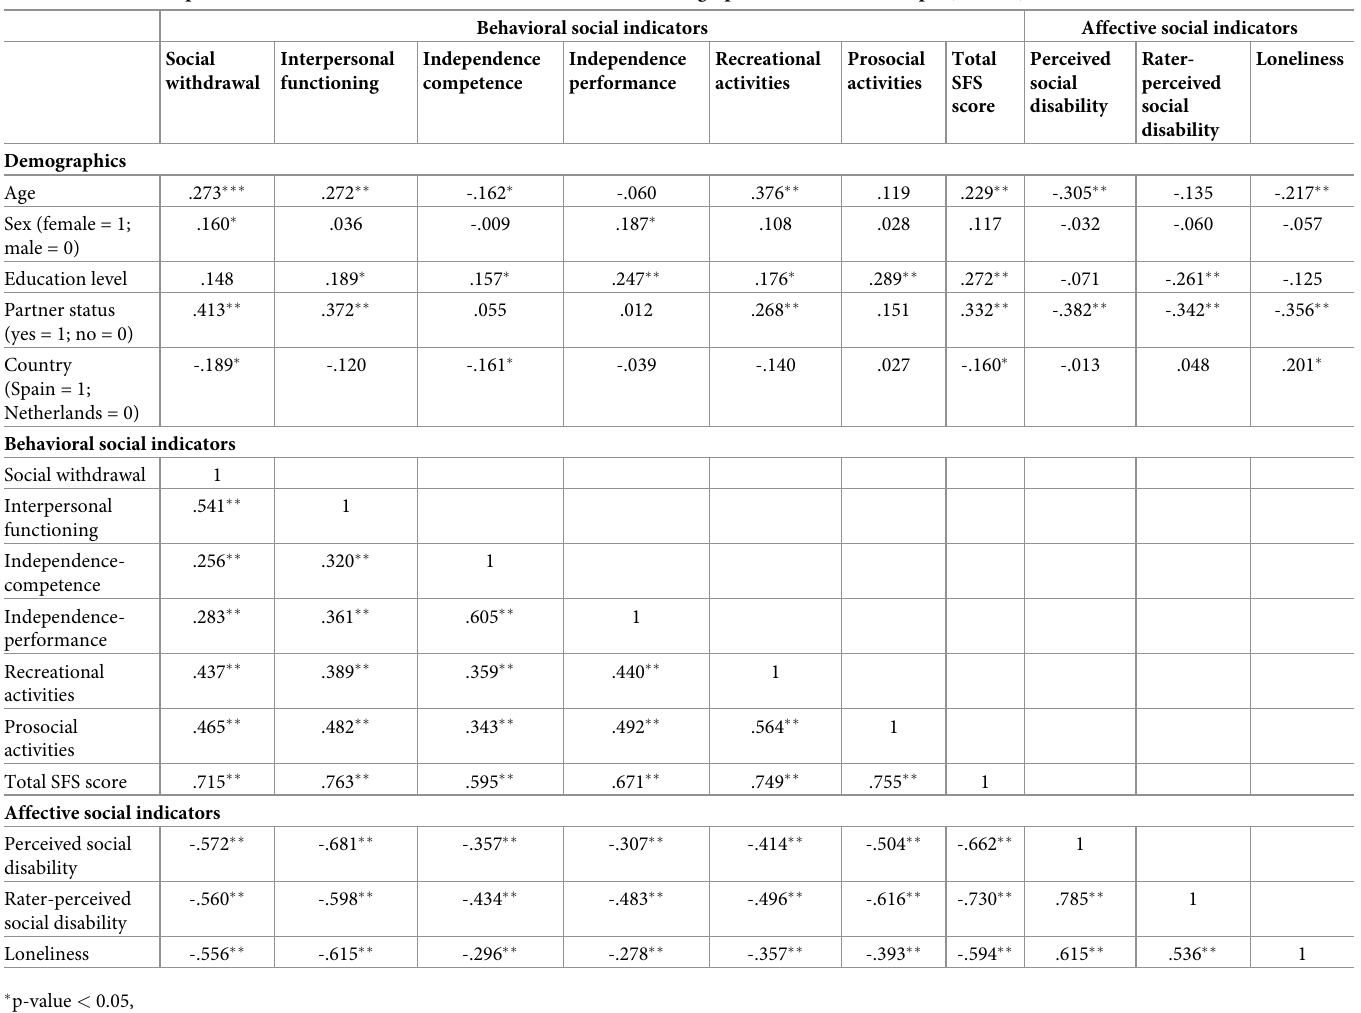
Table 2. Pearson and point biserial correlations between social indicators and demographics in the overall sample (N = 163).